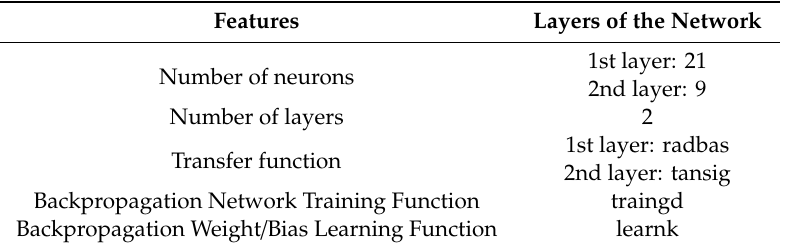
Table 12. The structure of the hidden layers of ANN-PSO algorithm to estimate the taste index.